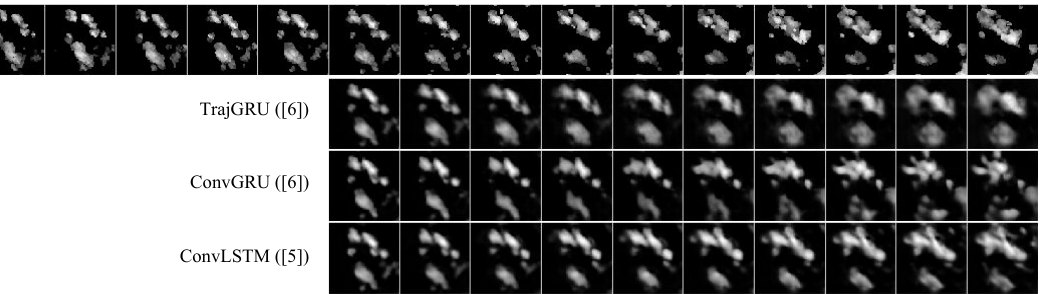
Figure 5. Example of predicted results of three models following Shi et al. [6]. In the the first row, the five left-most images are the input and then ten right-most images are the expected output. Predicted images of three models are drawn in the second through the fourth